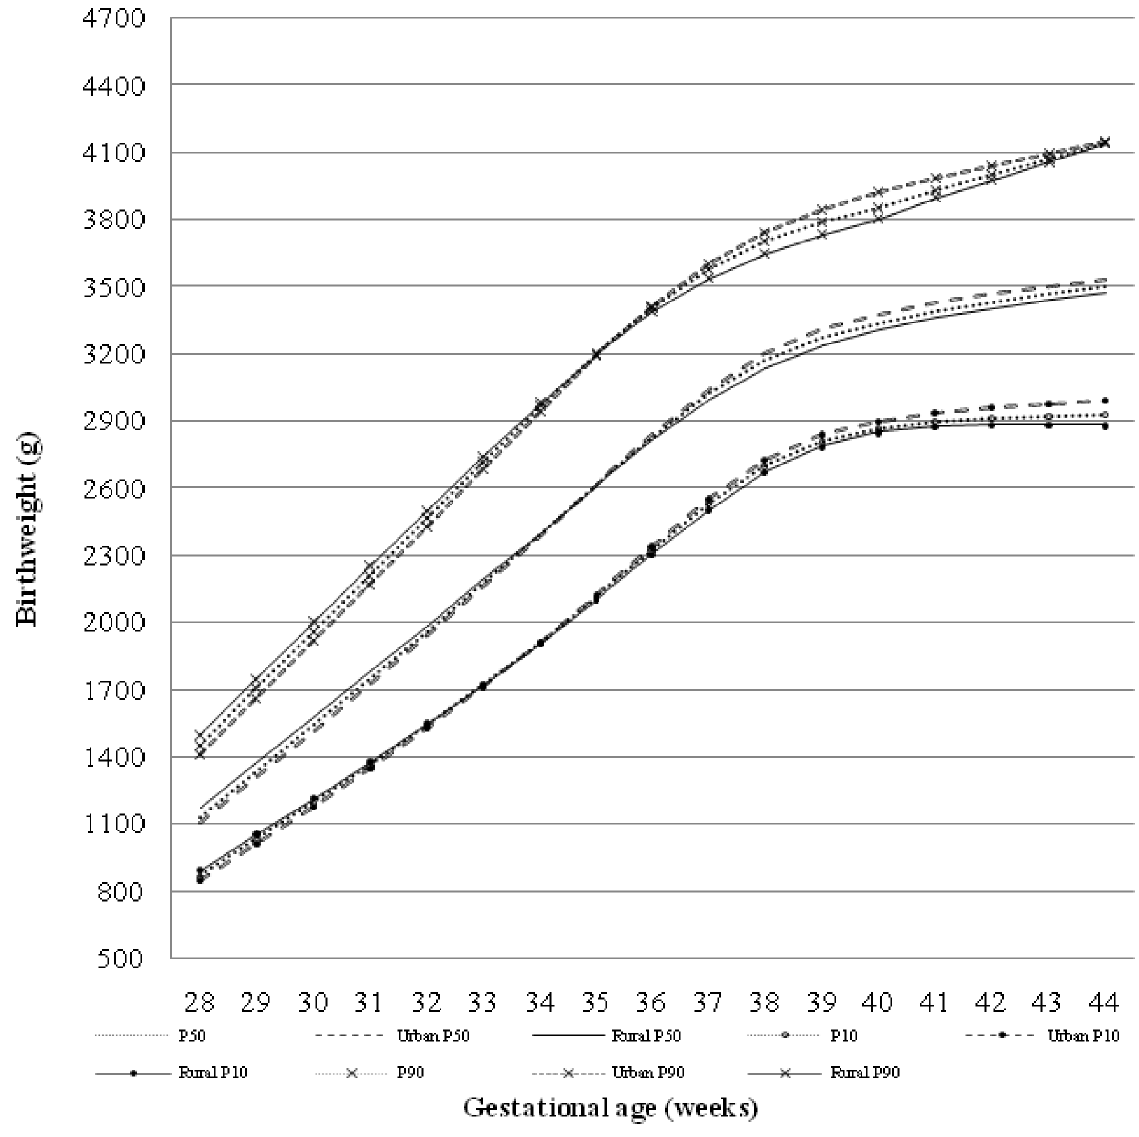
Figure 3. Urban-rural variations of the 10 th , 50 th and 90 th birth weight percentiles for Chinese infants irrespective of gender.